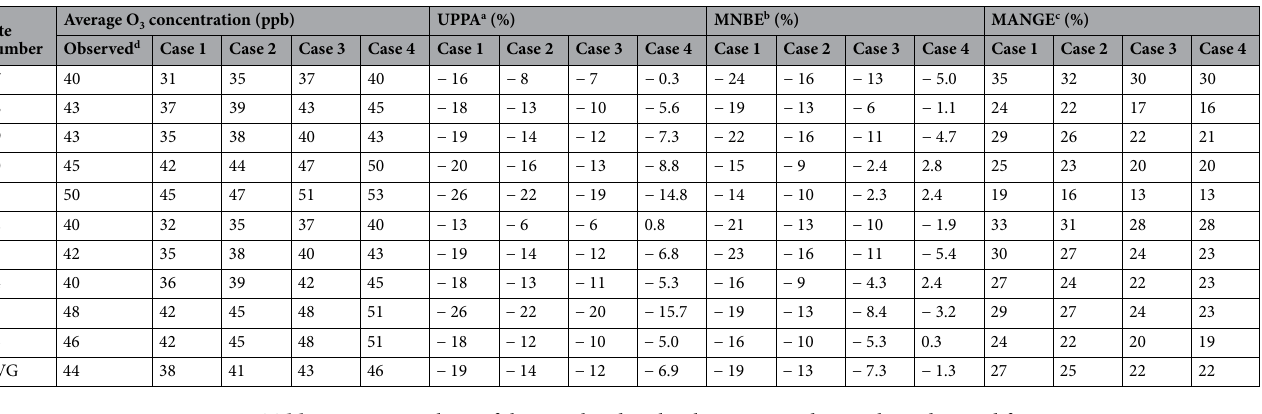
Table 5. Error analysis of the simulated O 3 levels at 10 sites during the 6-d period from May 24 to 29, 2003. a UPPA (unpaired peak prediction accuracy): UPPA = 1